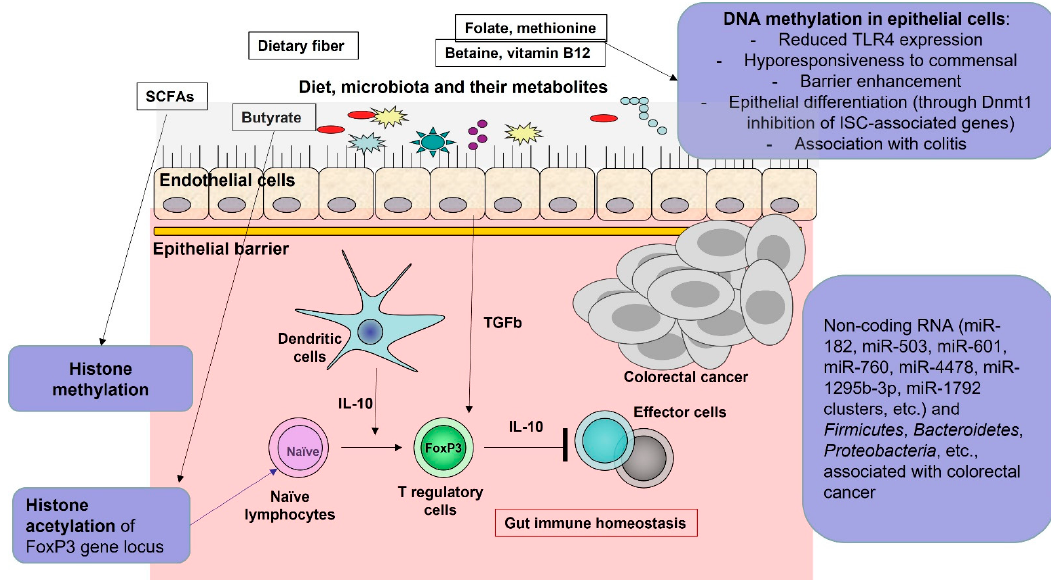
Figure 3. Cross-talk between microbiota and epigenetic modifications associated with gut homeostasis or disease (including cancer). Arrows represent influence or development, and an arrow followed by | represents suppression.